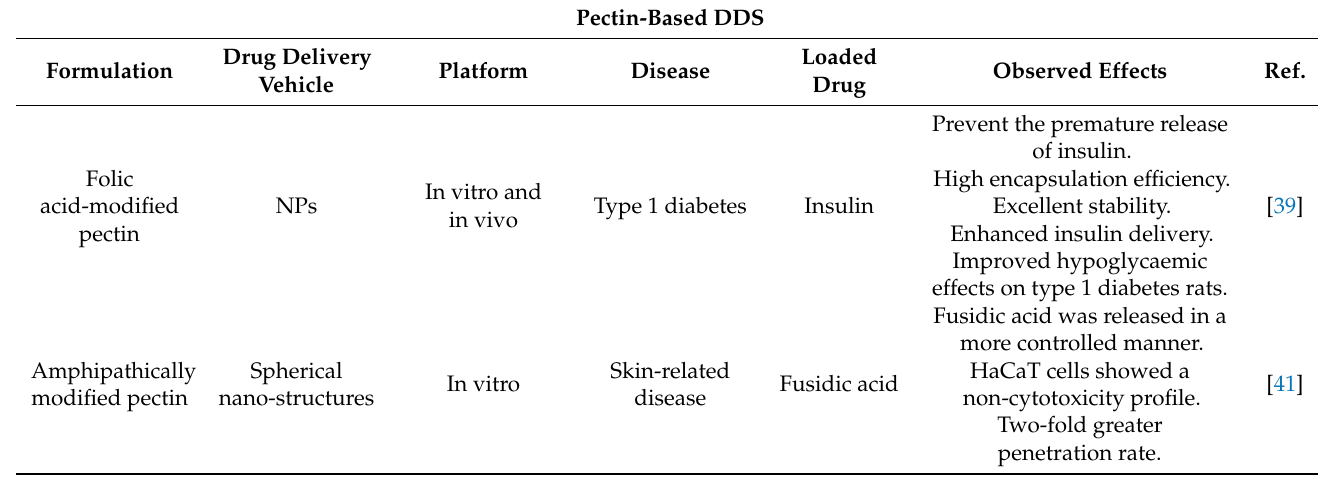
Table 3. Summary of studies on pectin-based